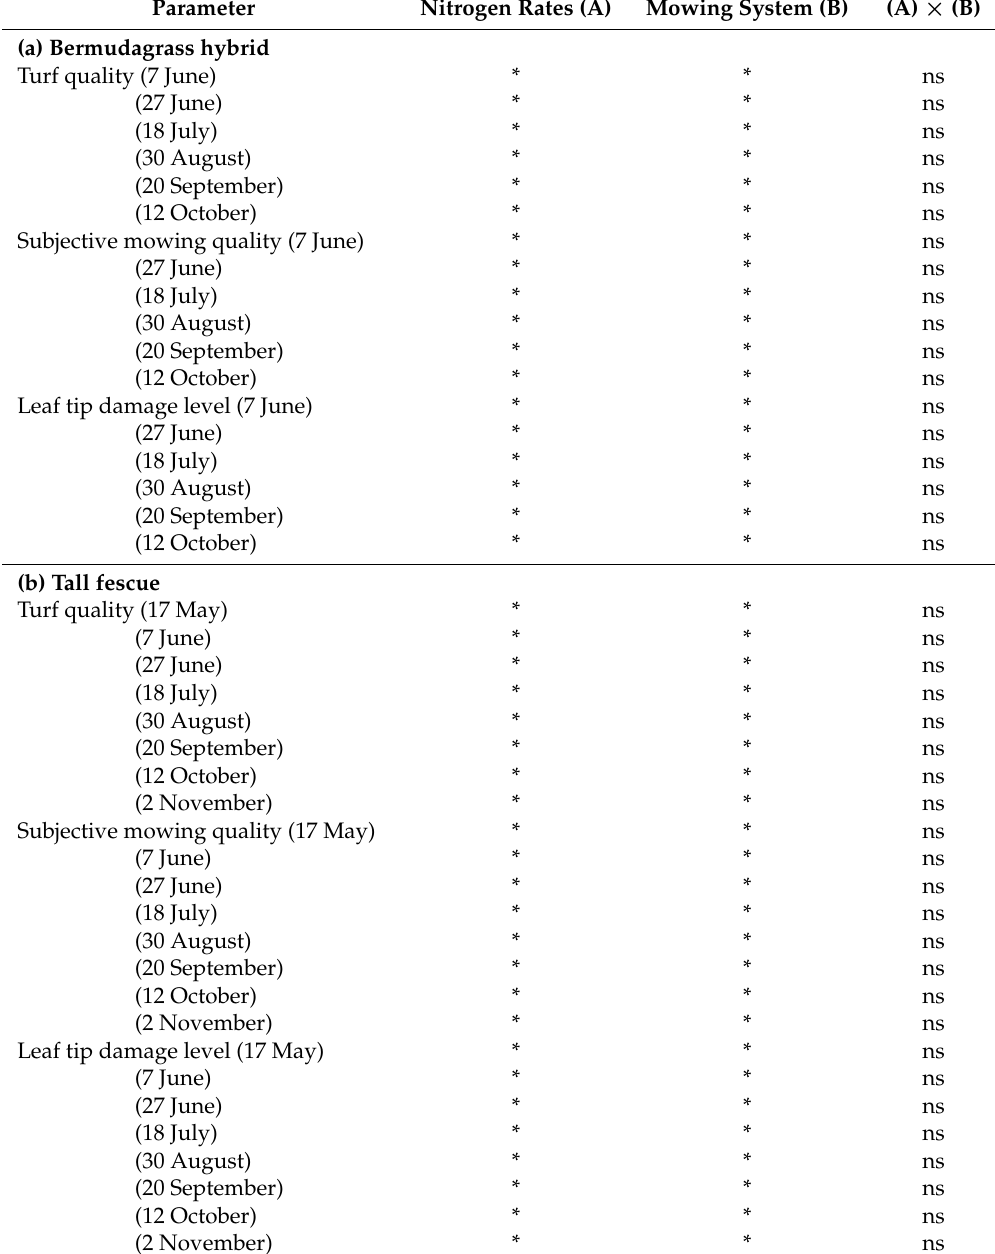
Table 1. Results of analysis of variance testing the effects of nitrogen rates, mowing system and their interaction on turf quality, subjective mowing quality and leaf tip damage level. The two species were analysed